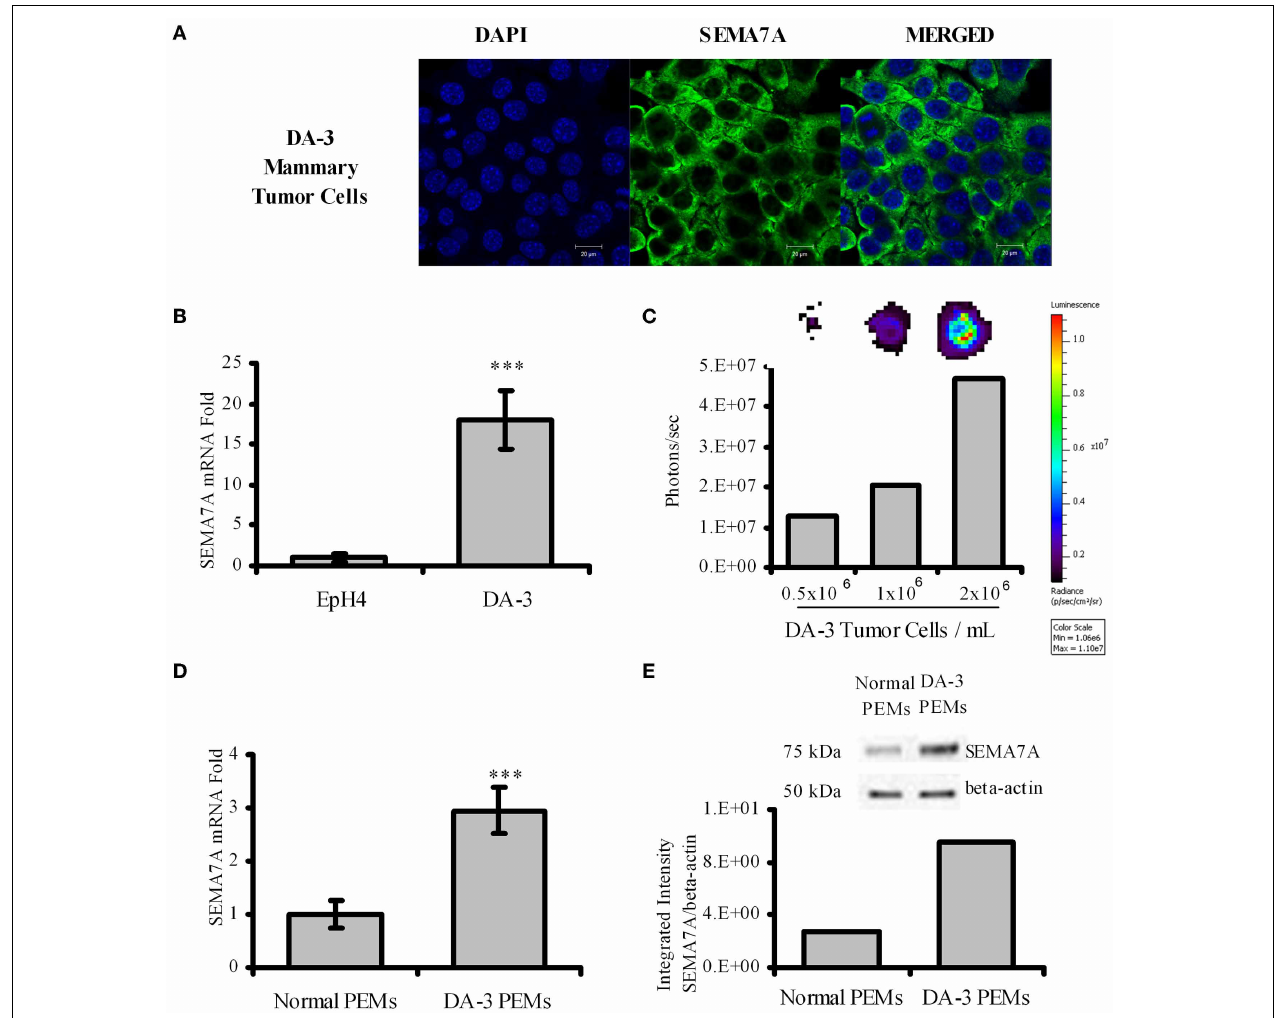
FIGURE 1 | DA-3 mammary tumor cells express SEMA7A. (A) Shown is the confocal images of DA-3 mammary tumor cells for SEMA7A expression; (B) SEMA7A expression in EpH4 and DA-3 mammary tumor cells as determined by qPCR; (C) DOT blot analysis of DA-3 mammary tumor cell culture showing that SEMA7A is solubilized; (D) mRNA expression of SEMA7A in peritoneal elicited macrophages (PEMs) from